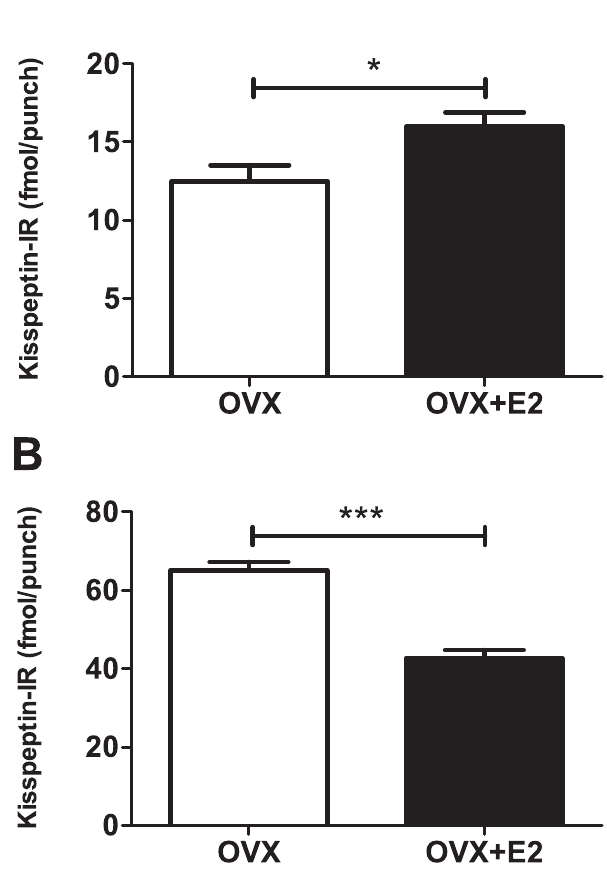
Figure 4. The effect of E 2 on kisspeptin-IR in the hypothalamus of OVX female rats. (A) E 2 significantly increased kisspeptin-IR in the AVPV. (B) E 2 significantly decreased kisspeptin-IR in the ARC. Quantification of kisspeptin-IR by RIA. (Mean S.E.M, n=6 – 8, *P , 0.05, ***P , 0.001, Student’s t-test).